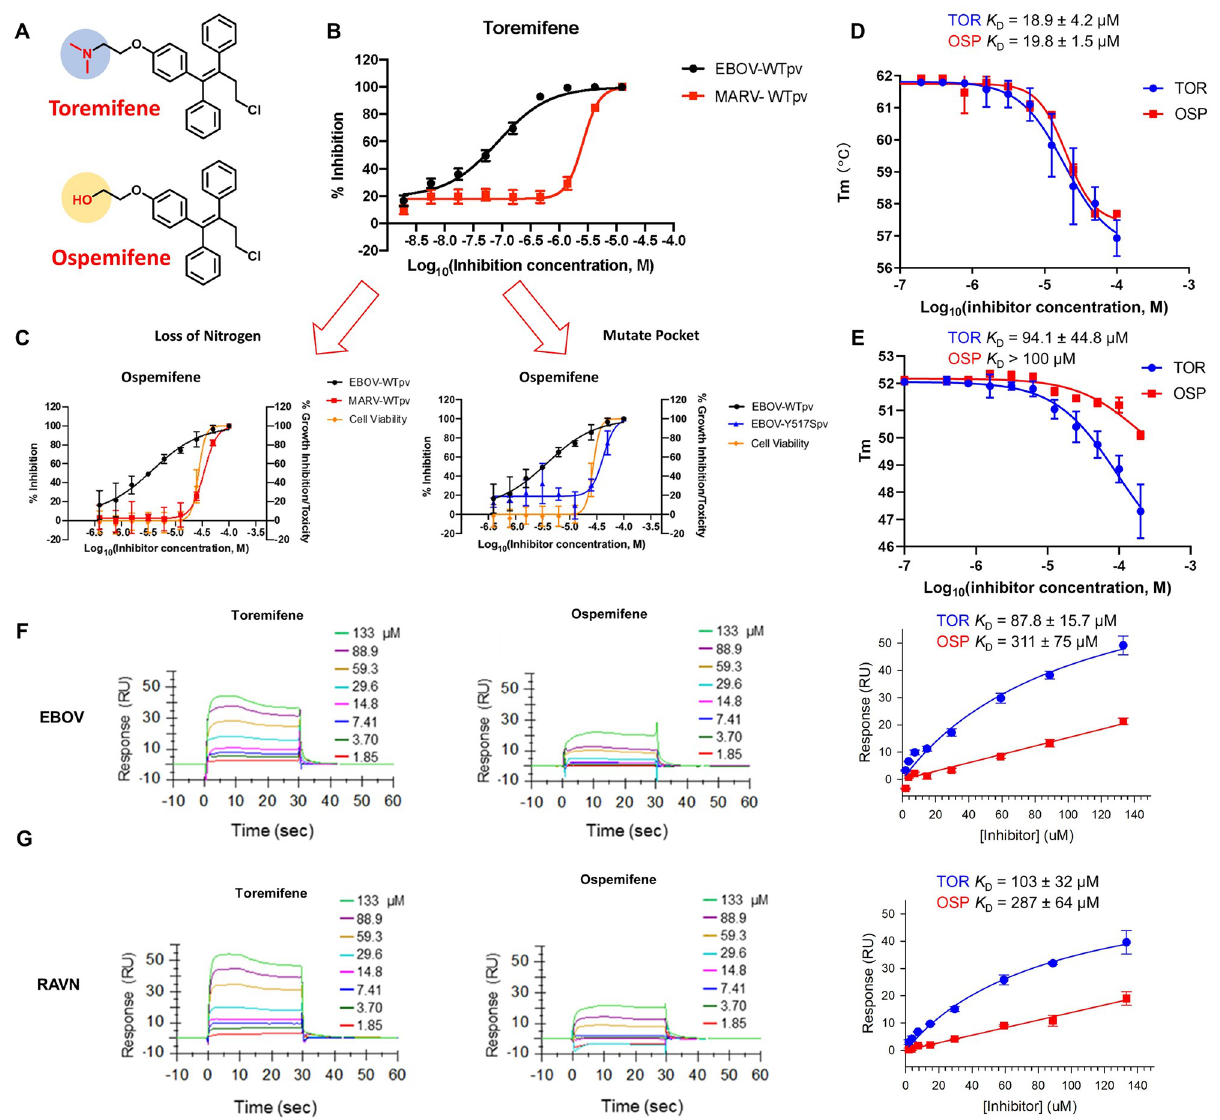
Fig 4. Analysis of toremifene analog ospemifene suggests terminal amine group is relevant to secondary mechanism of action but not direct binding to the EBOV GP. (A ) Structural comparison of toremifene and ospemifene with highlighted functional group discrepancy; ( B ) Toremifene dose-response curve against pseudotyped WT-EBOV and WT-MARV; ( C ) Ospemifene dose-response curves against WT-EBOV, WT-MARV, and cytotoxicity representing compound efficacy without the presence of a terminal nitrogen; Dose-dependent effects of toremifene (TOR) and ospemifene (OSP) on the melting temperature of purified EBOV GP Δ mucin ( D ) and RAVN GP Δ mucin ( E ); Dose-response sensorgrams and steady-state affinity fitting curves of toremifene and ospemifene binding to the purified EBOV GP Δ mucin ( F ) and RAVN GP Δ mucin ( G ) from surface plasmon resonance (SPR) binding analysis. The compounds were analyzed in a series of increasing concentrations from 1.85 to 133 μ M; All error bars represent S.D. from three independent experiments.